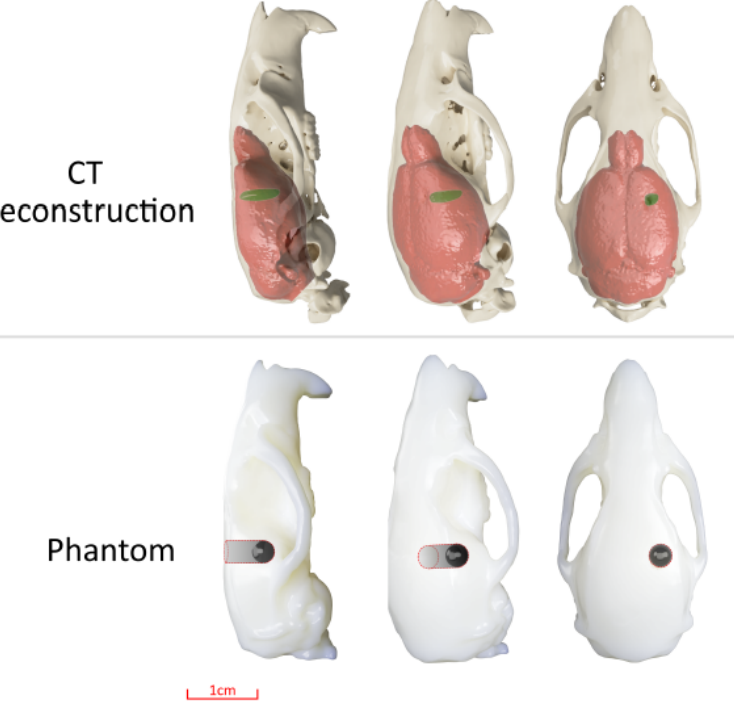
Figure 6. The three top images are CT reconstructed volumes of tumour a bearing rat skull, high- lighting the brain volume (red) and tumour volume (green) for a range of angles from LR to AP. The three lower images are the corresponding angles of a plastic rat skull phantom with a hole (red) and implanted 3.2mm diameter ball bearing (grey) location super-imposed over each